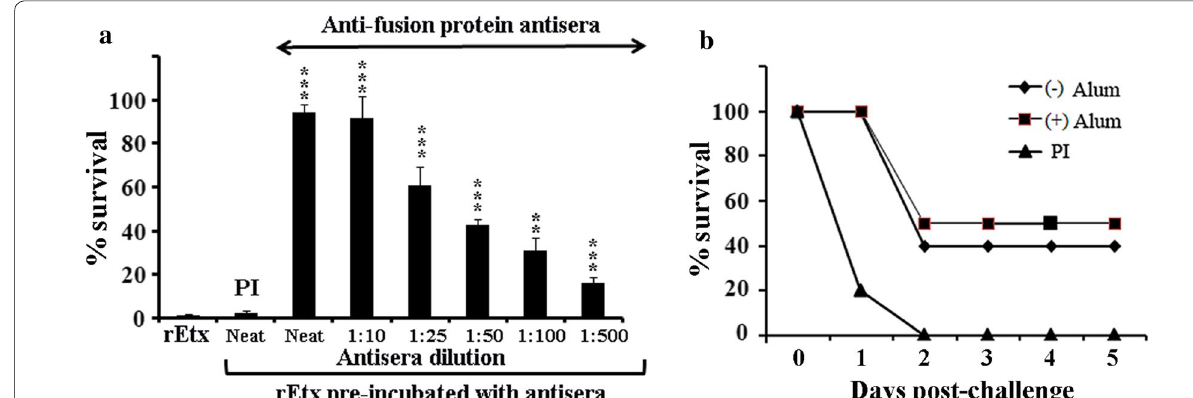
Fig. 5 Toxin neutralization capacity of anti-rLTB.Etx 40–62 antibodies: a in vitro neutralization ability of the anti-fusion protein antisera against the epsilon toxin was determined by incubating the rEtx (75 ng/ml) with different dilutions of anti-fusion protein antisera [undiluted (neat), 1:10, 1:25, 1:50, 1:100 and 1:500] prior to its addition to the MDCK cells. The cells were then incubated for 1 h at 37 °C and cell viability was determined by MTT assay. Cells treated with the rEtx pre-incubated with the undiluted pre-immune sera (PI, neat) were included as control. Percent survival of MDCK cells was plotted with respect to untreated control cells. Ordinary one-way ANOVA was performed to determine the statistically significant change ( p value) in the survival with respect to rEtx-treated cells. ** p 0.005; *** p 0.001. b BALB/c mice (n 10 per group) were challenged with ≤ ≤ = the 2 LD50 dose of the rEtx (3 ng/20 g body weight in 5 µl PBS; intraperitoneal) pre-incubated with equal volume of undiluted anti-fusion protein × antisera, generated with or without alum or preimmune serum (PI) at 37 °C for 1 h. The mice were monitored for survival for 5 days. Percentage survival was calculated according to the observed